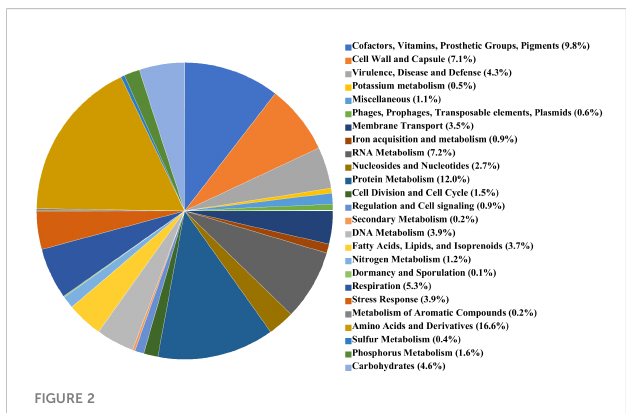
FIGURE 2 RAST subsystems in A. butzleri P1200 represented as pie chart. The 25 most abundant subsystems identi fi ed by the SEED Viewer version 2.0 are represented by a speci fi c color as indicated in the color legend at the right